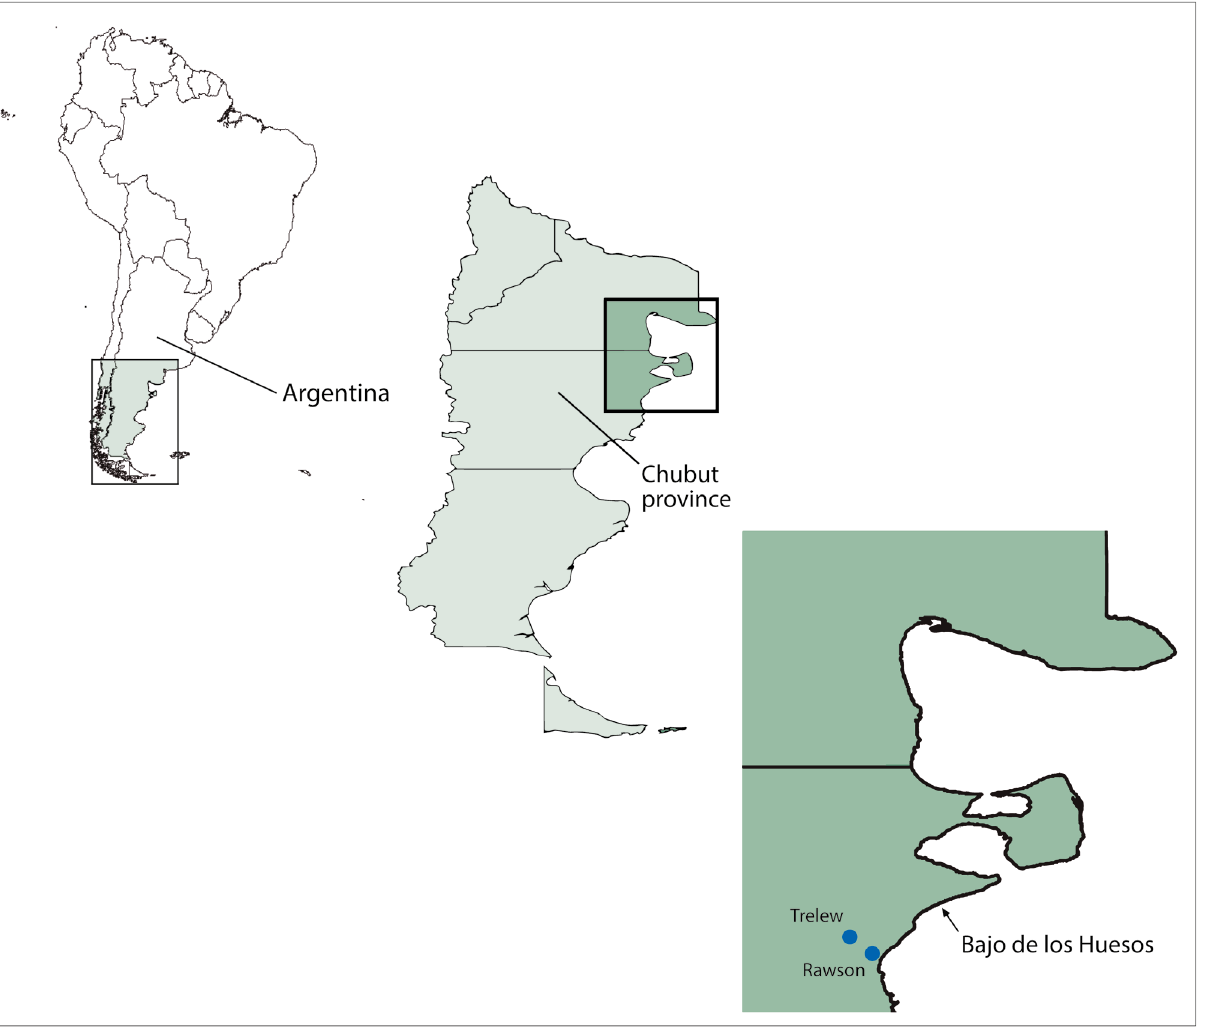
Figure 2. Aeginecta longicauda n. gen., n. sp. location of type